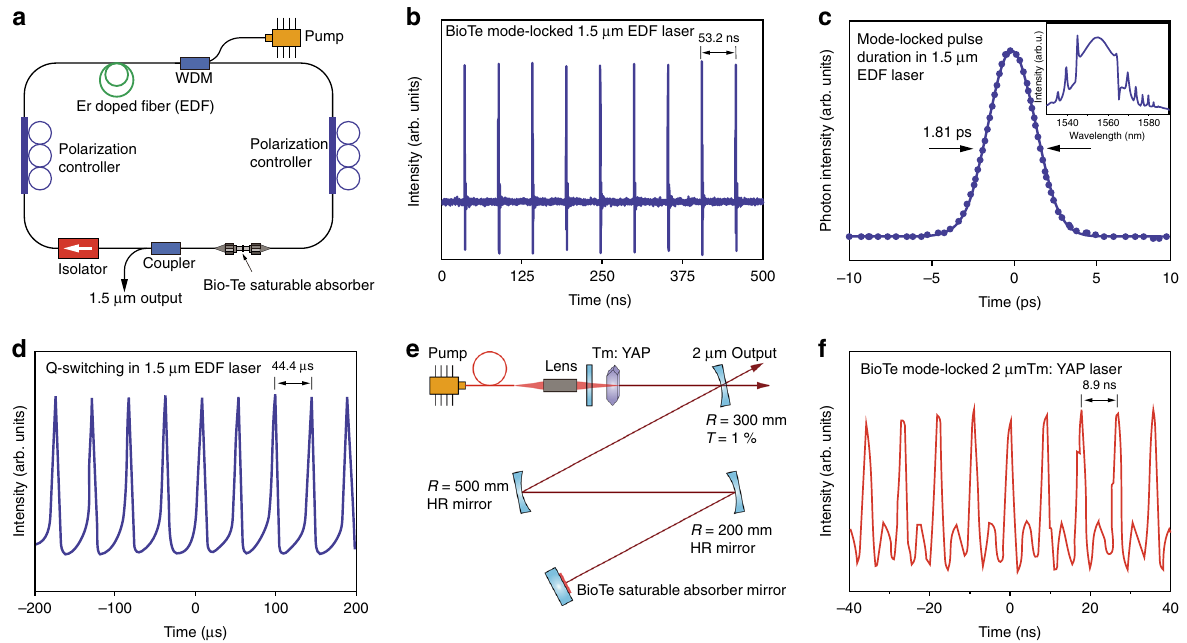
Fig. 4 Ultrafast laser pulse generation using biologically synthesized tellurium. a Scheme of the erbium-doped fi ber laser with a Bio-Te-saturable absorber. b Mode-locked pulse train generated by the erbium fi ber laser with repetition rate of 18.8 MHz. c Auto-correlation measurement of Bio-Te mode-locked laser pulses. The sech 2 fi tting indicates a 1.81 ps pulse width. The inset shows the spectrum of the mode-locked pulses. d Q-switched pulse train generated in the EDF fi ber laser. e Diagram of the Tm: YAP 2 μ m laser with Bio-Te saturable absorber mirror acting as a passive optical modulator. f Mode-locked pulses generated in the same Tm: YAP laser with the a ~112.3 MHz repetition rate and 1.6 ns pulse